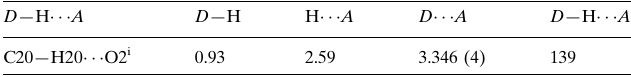
Hydrogen-bond geometry (A˚ , (cid:2)